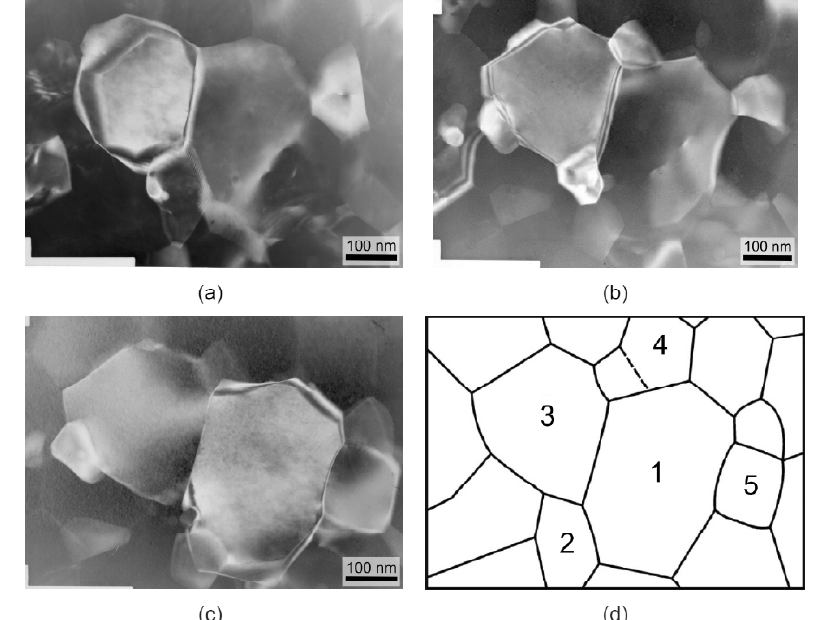
Fig. 1. TEM images of the microstructure of UFG aluminum alloy Al-4%Cu-0.5%Zr: (a) as-prepared state after HPT ( e  7); after the first (b) and the second (c) anneals for 120 seconds; (d) schematic illustration of the studied region. The dashed line in (d) separates the particle of the second phase from the grain